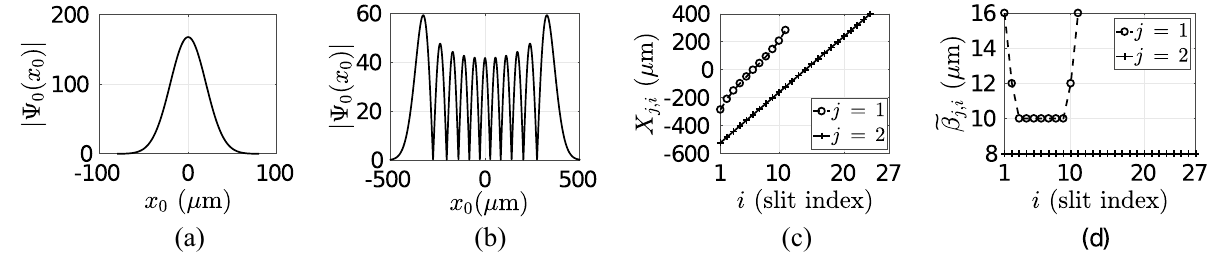
10 ) source waveforms with σ 0 = 11 and K 2 27 slits ( d ) and the widths = =